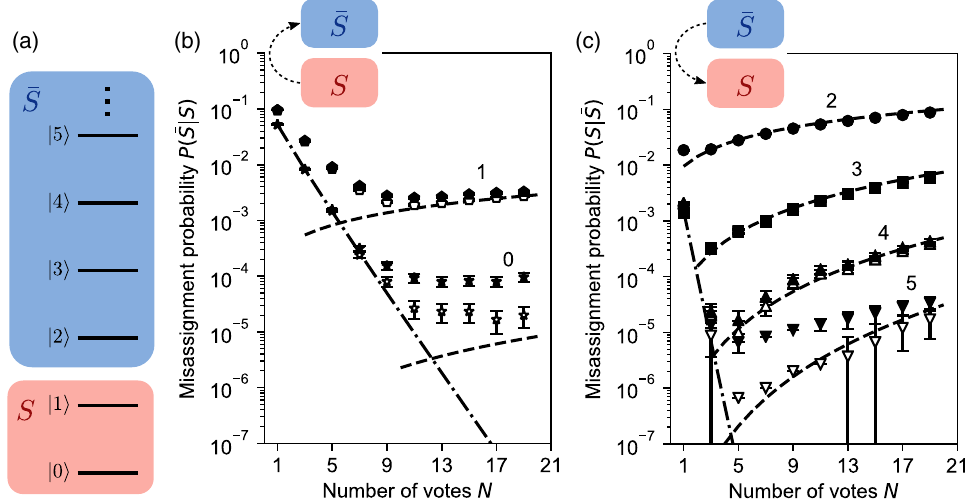
FIG. 5. Enhancement of measurement fidelity with the code distance. (a) In these experiments, we excite the ancilla if the storage ¯ S as shown. (b) Probability that, when mode has fewer than two photons in it. In doing so, we read out whether the storage state is in S or ¯ S . The state j 0 i or j 1 i is prepared in the storage mode, as indicated a state in S is prepared in the storage mode, it is assigned incorrectly as by the labels on the plot. The data show that the fidelity improves exponentially with the number of votes, until excitation out of the S subspace limits the measurement. Dash-dotted lines show the terms in the theoretical prediction corresponding to majority voting, dashed lines show terms corresponding to state transitions, and closed symbols show the experimental data. Open symbols indicate ¯ S is prepared in the storage mode, it is assigned incorrectly postselection on successful ancilla resets. (c) Probability that, when a state in as S . Again, we see that majority voting suppresses the misassignment probability but that for large N the misassignment probability increases due to photon loss. States of higher photon number are measured with a smaller error, because the measurement is robust to more photon-loss